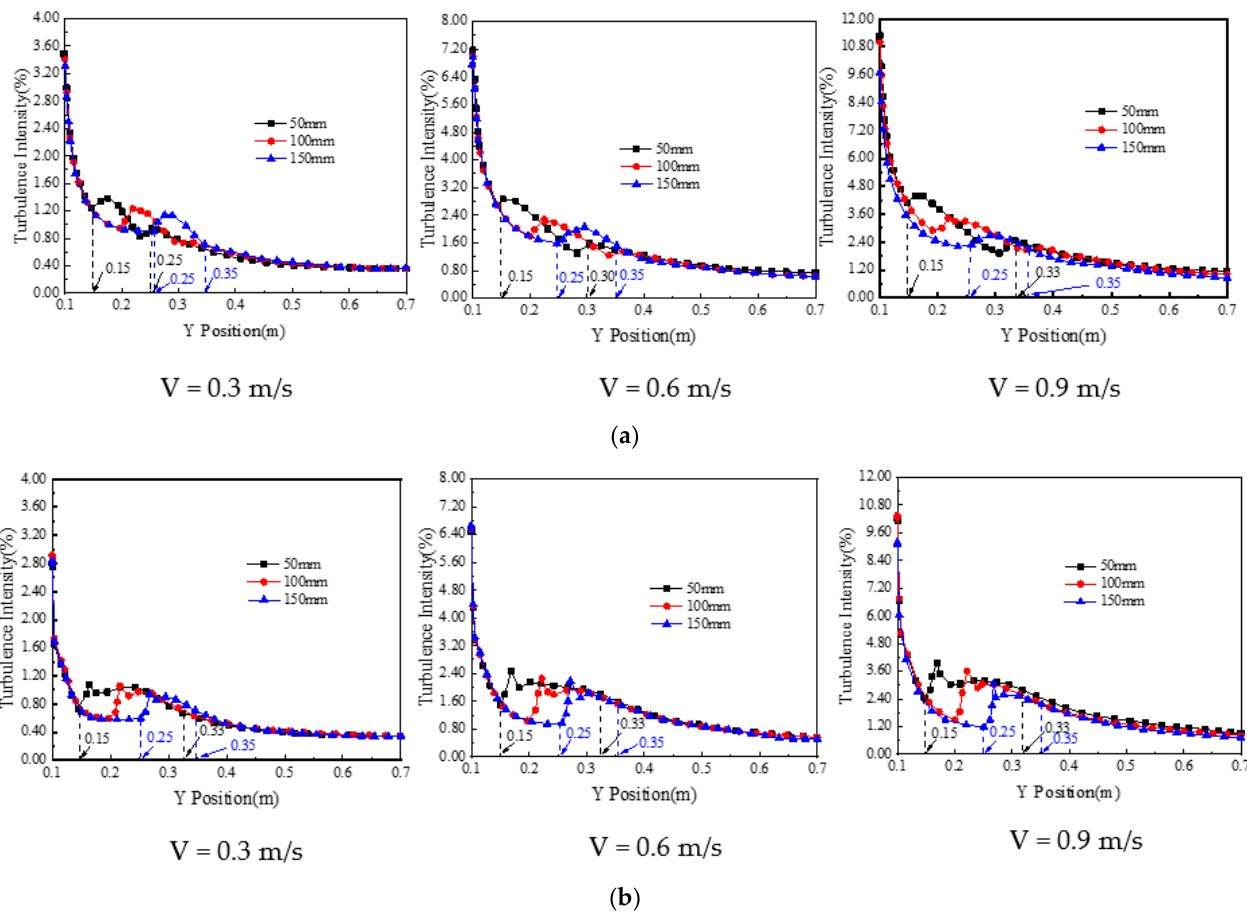
Figure 6. Charts showing the changes in turbulence intensity with the length of the TES. ( a ) Changes in turbulence intensity corresponding to L 1 . ( b ) Changes in turbulence intensity corresponding to L 2 .